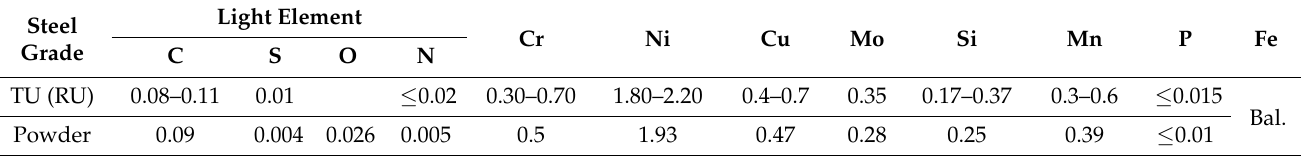
Table 1. Chemical content of experimental steels, mass % (*).